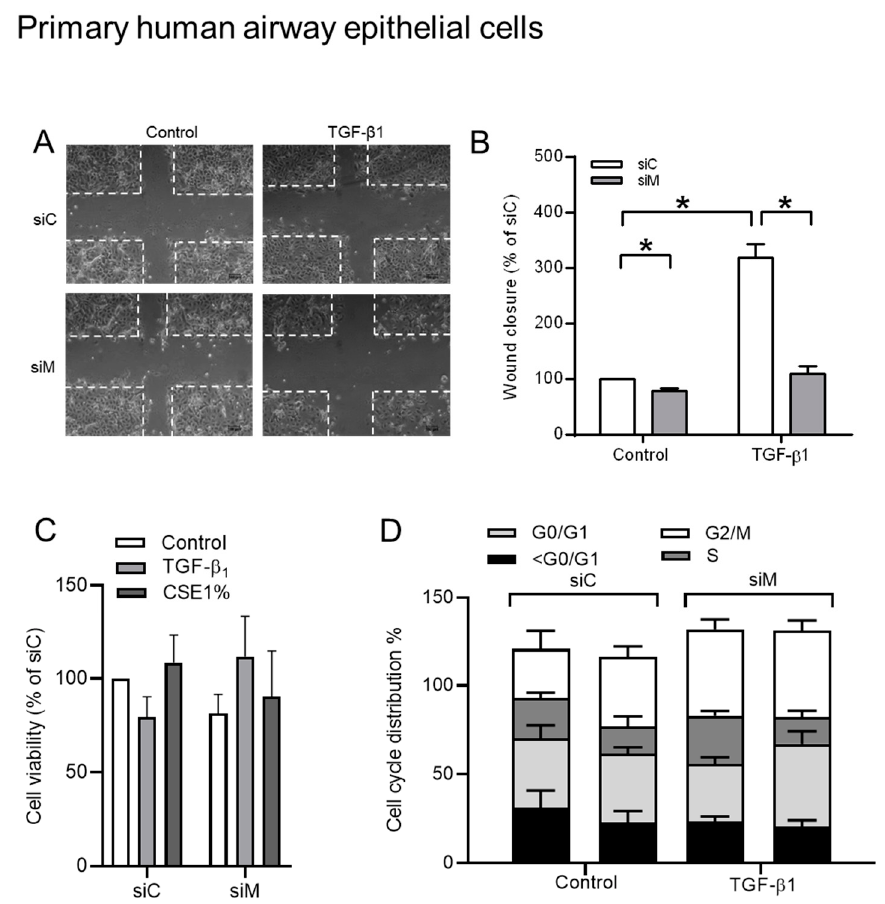
Figure 9. The role of Ezrin, AKAP95, and Yotiao in TGF- β 1-induced cell migration while using pHAE cells. ( A ) Representative images of wound healing assay after 24 h post scratch. The white dotted line indicated borders of scratches at 0 h. ( B ) Quantification of wound closure of TGF- β 1 treated cells in co-cultured with combined knockdown of Ezrin, AKAP95 and Yotiao. ( C ) MTT assay in pHAE cells that were transfected with a combination siRNA of Ezrin, AKAP95, and Yotiao together with 3 ng/mL TGF- β 1. ( D ) Cell cycle distribution in pHAE cells transfected with a combination siRNA of Ezrin, AKAP95 and Yotiao together with 3 ng/mL TGF- β 1. Data represent 3–5 independent experiments. The data are expressed as mean ± SEM, * p < 0.05; significant difference between indicated groups.